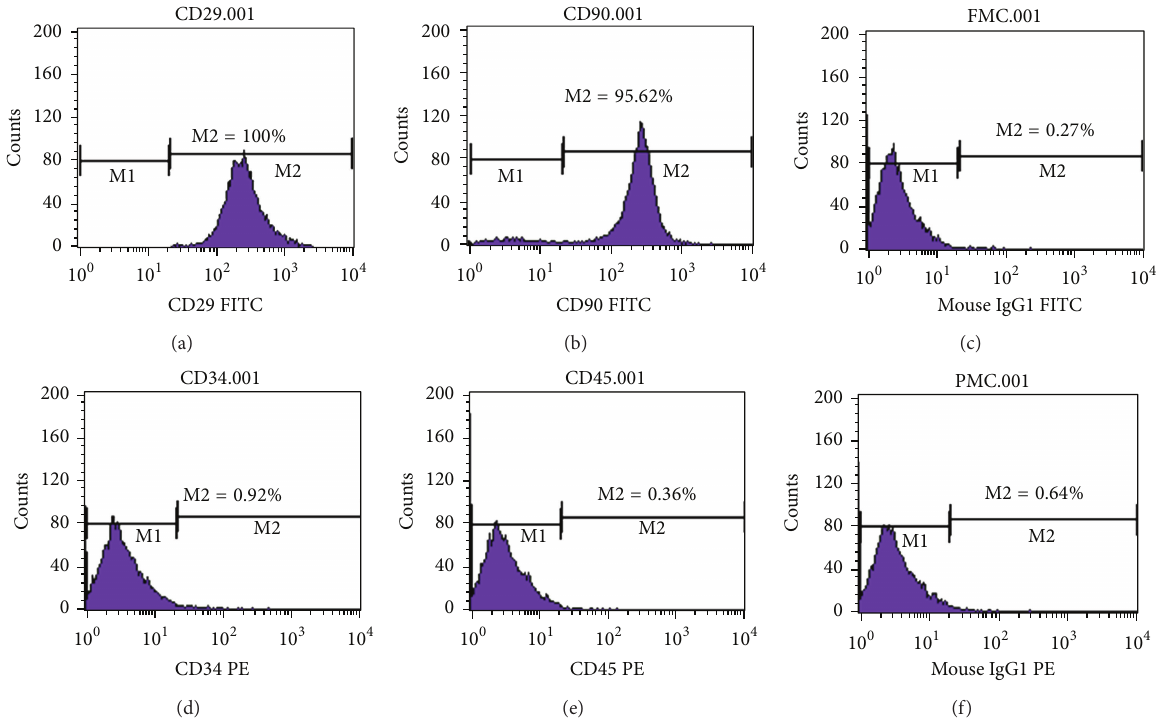
Figure 1: Identification of MSCs. The purified MSCs were identified by flow cytometry. MSCs were derived from the bone marrow of adult SD rats. (a) CD29 positive percent is 100%, (b) CD90 positive percent is 95.62%, (d) CD34 positive percent is 0.92%, and (e) CD45 positive percent is 0.64%.